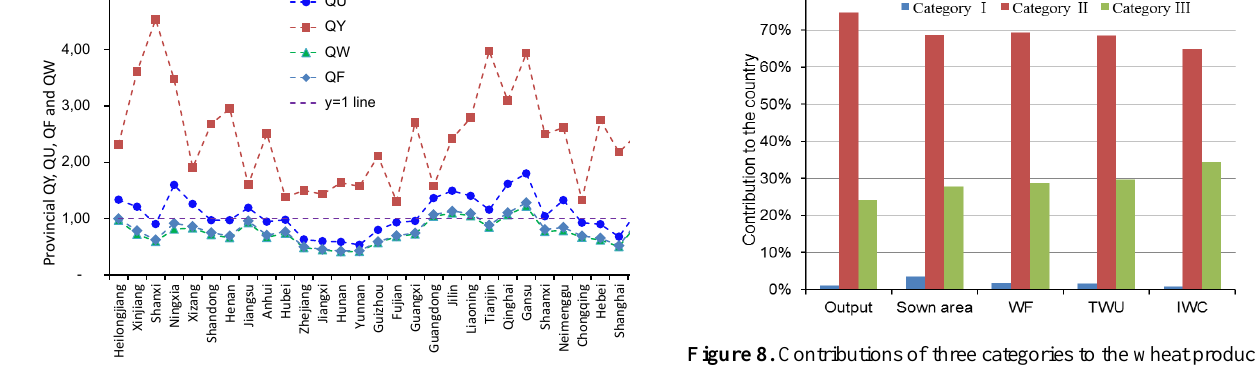
Figure 7. Provincial value of QU, QW, QY and QF in 2010.